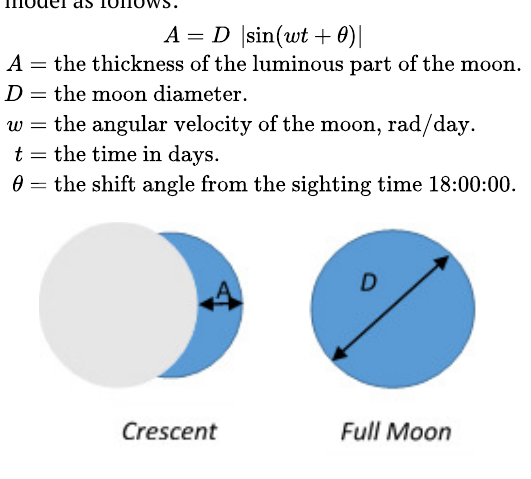
Figure 1. Luminus